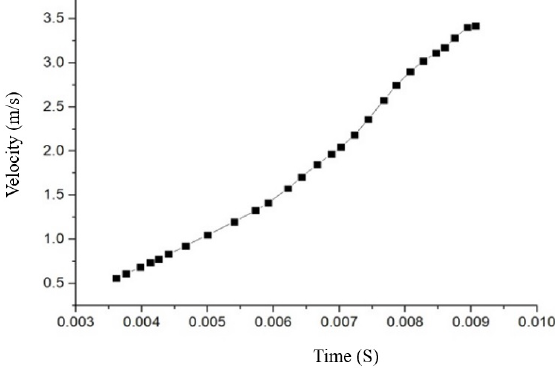
Fig. 20. Velocity test of the nail shooting